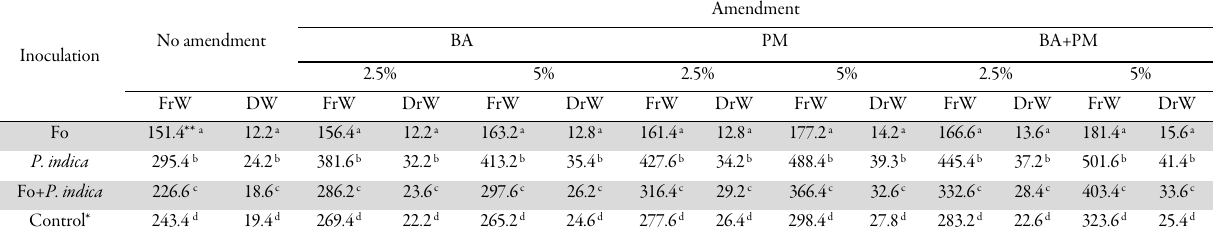
Fo 134.6** a P. indica Fo+ P. indica * No inoculation with Fo and P. indica . ** Means of 6 plants per treatment each from two separate experiments. Letters a, b, c and d of values are the rank of significant difference according to ANOVA (L.S.D. p = 0.05). Table 9b. Effect of seed inoculation of cucumber with P. indica and soil amendment with organic wastes on fresh weight (FrW) and dry weight (DrW) per plant six weeks after sowing (non-autoclaved soil)